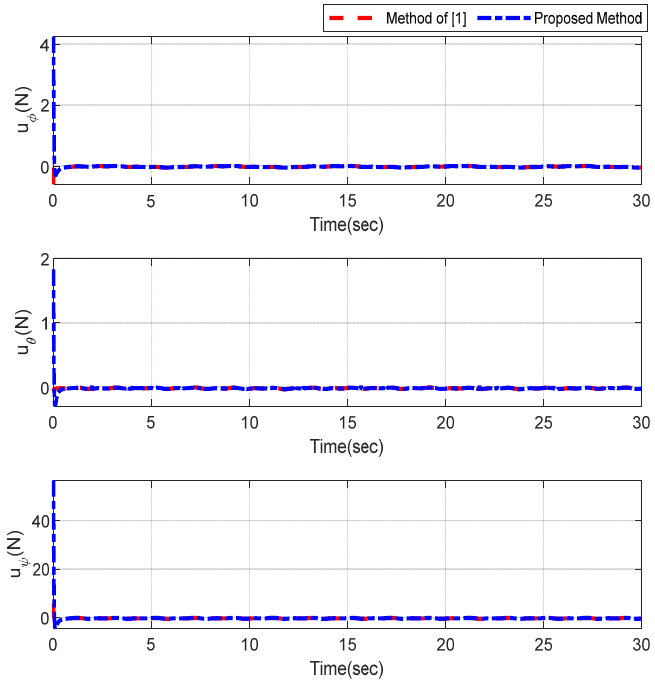
Figure 9. Control inputs relevant to attitude of quadrotor.